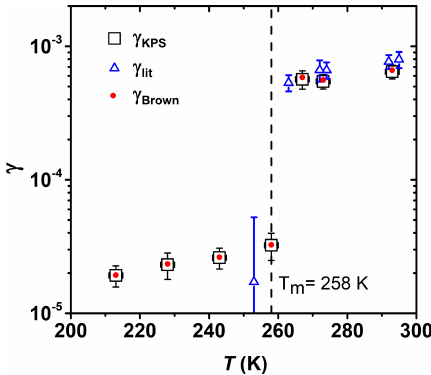
Figure 7. Reactive uptake coefficients of O 3 by canola oil as a function of temperature. Squares and red circles represent γ val- ues derived using the KPS and Brown methods, respectively. See text for more details. γ lit represents values reported by de Gouw et al.